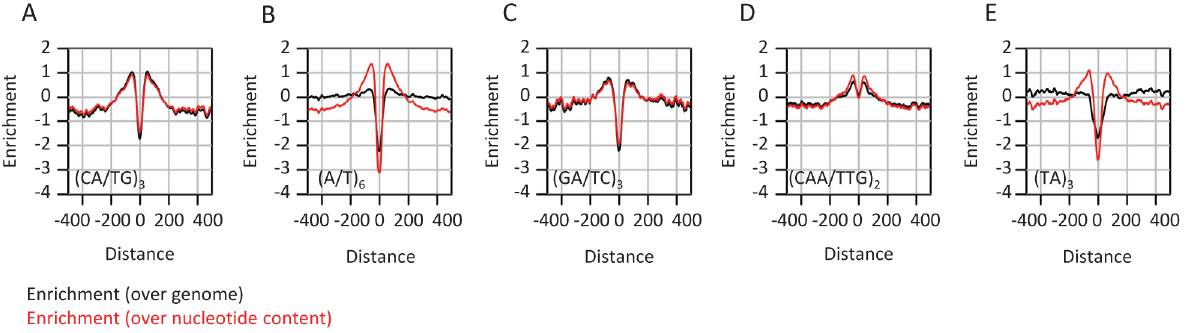
Figure 4. Enrichment of microsatellites in the proximity of conserved elements. A–E) Shown in black are distributions of enrichment (log2 of the ratio between the frequency at a certain distance from a CE and the global average) computed for various tandem repeats and motifs around CEs (black). Shown in red are similar statistics, but this time normalized according to the nucleotide compositions of the corresponding distance around CEs (i.e. dividing the frequency of each k-mer by the product of its nucleotides’ frequencies). The data suggest remarkably uniform enrichment of tandem repeats around CEs.